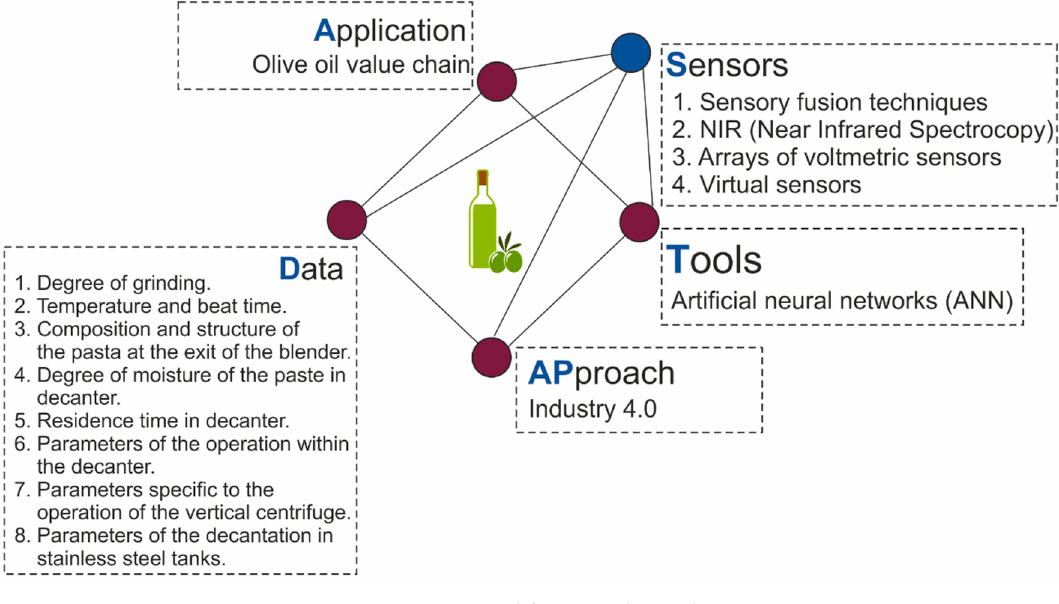
Figure 12. Conceptual framework. Study case.